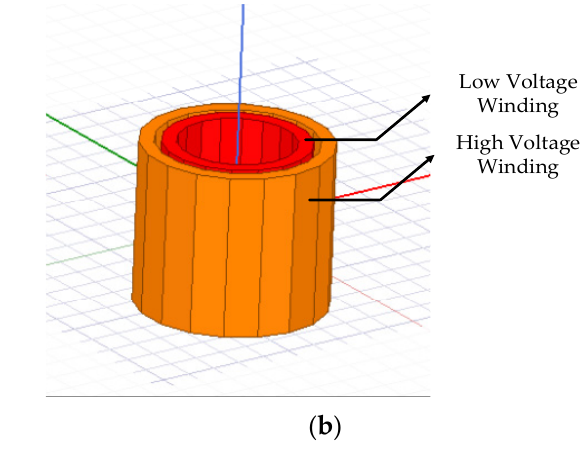
Figure 4. Winding Design: ( a ) Toroidal Winding ( b ) Shell Type Winding.